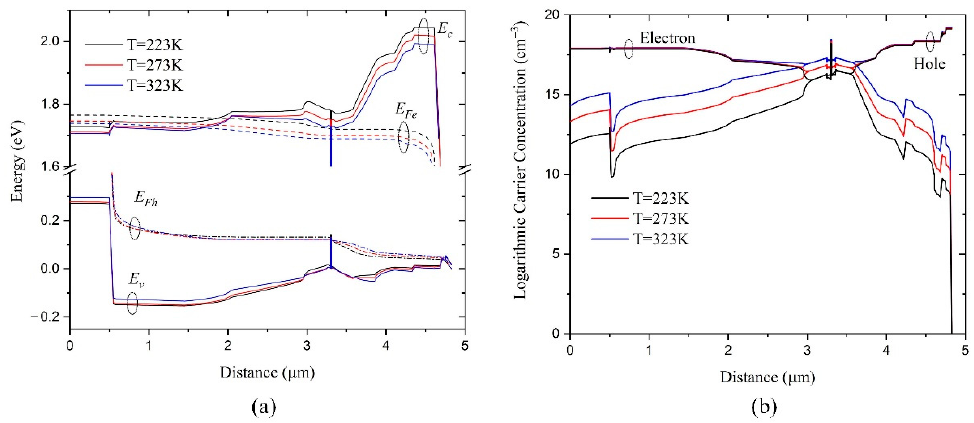
Figure 3. Temperature effects in the epitaxial direction at an injection current of 10 A ( a ) energy band structure ( b ) carrier concentration (the position of 0 μ m is located at the start position of the N-buffer layer, while the ordinate of Figure 3a has a break range from 0.4 to 1.6 and the ordinate of Figure 3b is logarithmically transformed by 10).